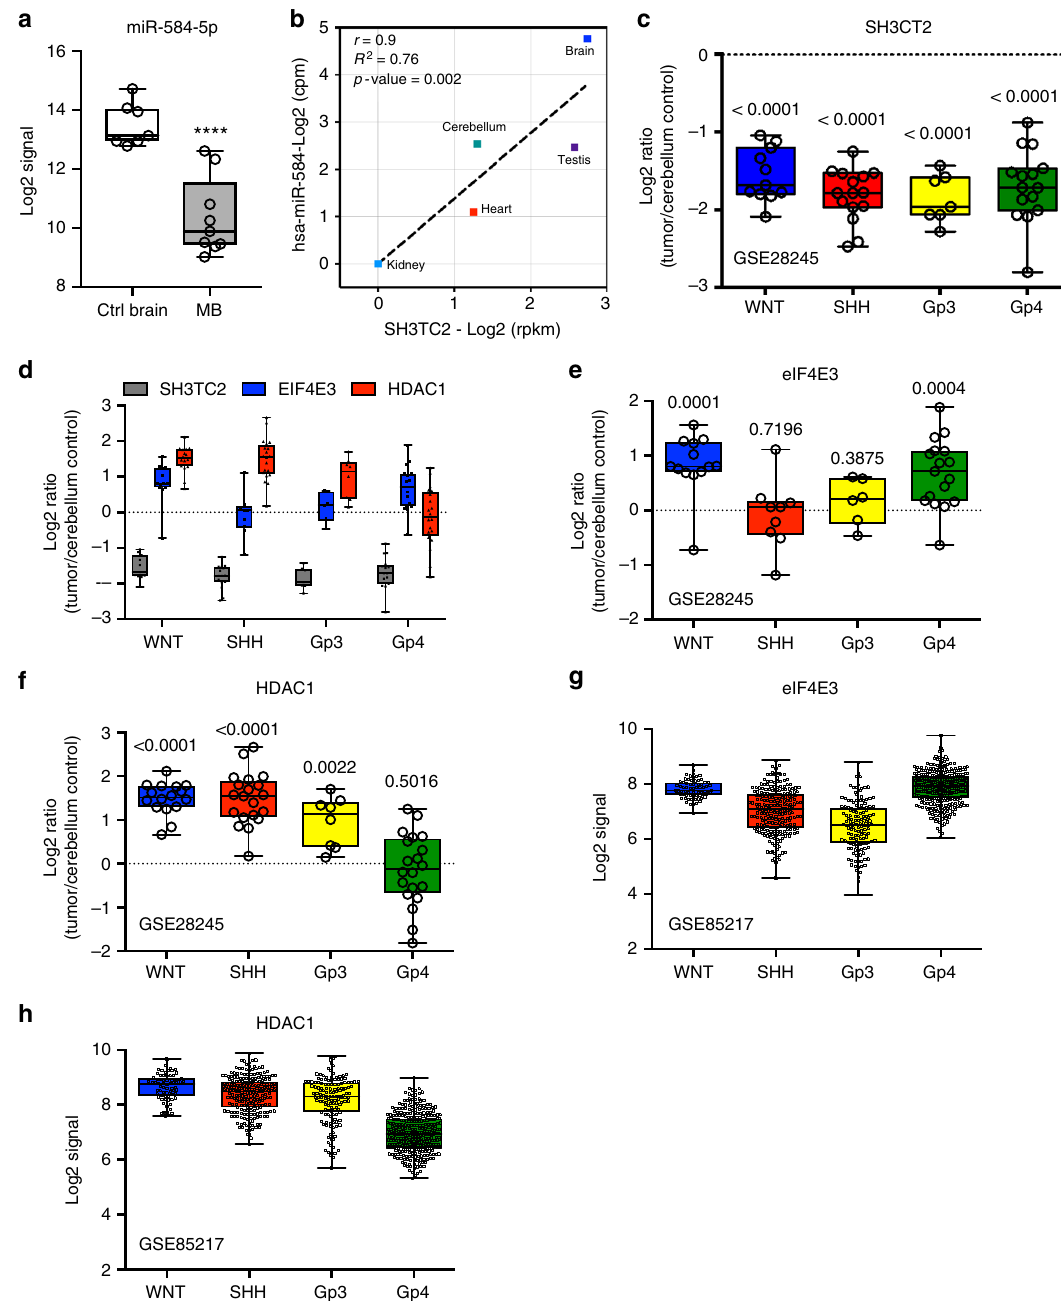
Fig. 10 Lower miR-584-5p expression parallels with higher eIF4E3/HDAC1 levels in MB. a Meta-analysis of GSE42657 data set showing miR-584-5p expression levels in human MB samples and control cerebellum. Data represent Log2 ratio of tumor/cerebellum. b Meta-analysis of miRIAD: intragenic microRNA database showing correlation between miR-584-5p expression and the expression of its host gene SH3TC2. c Meta-analysis of GSE28245 data set showing SH3TC2 expression levels in different sub-types of MB samples (WNT: n = 16; SHH: n = 20; Gp3: n = 20; Gp4: n = 20) and control cerebellum. Data represent Log2 ratio of tumor/cerebellum control. p -values are calculated using the Wilcoxon-signed rank test (theoretical median = zero). d Meta-analysis of GSE28245 data set showing SH3TC2, eIF4E3, and HDAC1 expression levels in different sub-types of MB. Data represent